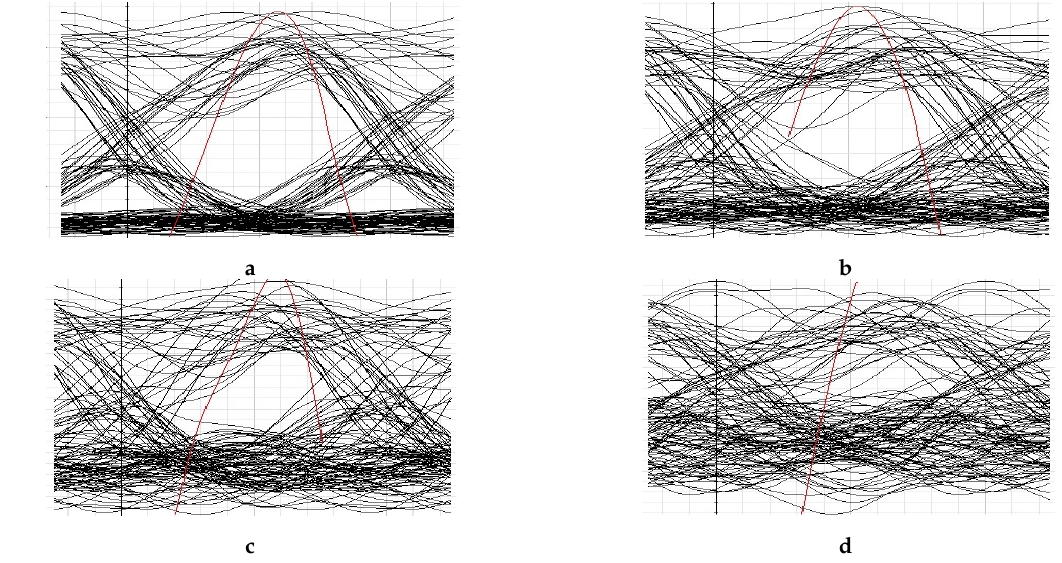
Figure 8. Estimation of eye diagrams; ( a ) WDM-FSO outcomes with suppressed RB and clear weather, ( b ) WDM-FSO outcomes with suppressed RB and rainy weather, ( c ) WDM-FSO outcomes without suppressed RB and clear weather, and ( d ) WDM-FSO outcomes without suppressed RB and rainy